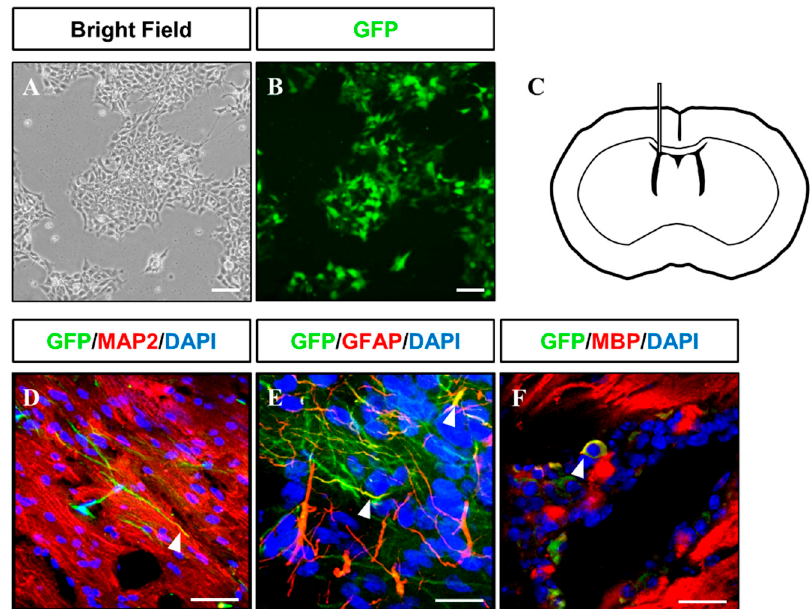
Figure 6. Injection of GFP-tagged iNSC into immunodeficient mouse brains. ( A , B ) Microscopy analysis of GFP-tagged iNSCs produced via lentiviral infection. ( C ) Schematic representation of iNSC transplantation. ( D – F ) At two months after transplantation, injected GFP + iNSCs were positive for MAP2, GFAP, and MBP, as determined by immunofluorescence analysis. Scale bars, 200 μ m.